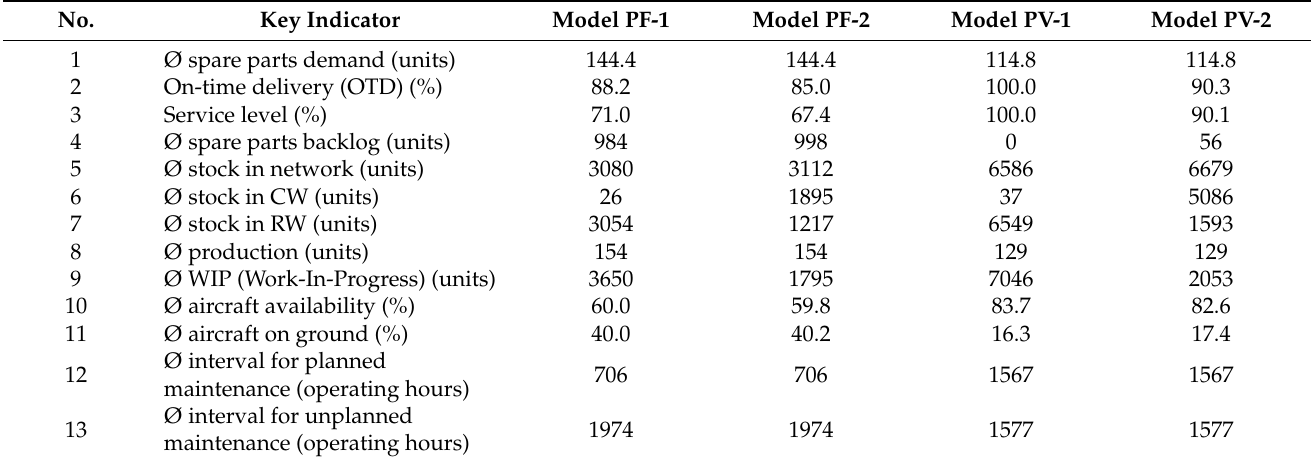
Results of the simulation model in the selected scenarios are shown in Tables 2 and 3. Table 2. Simulation results for the first demand scenario—high demand for spare parts.